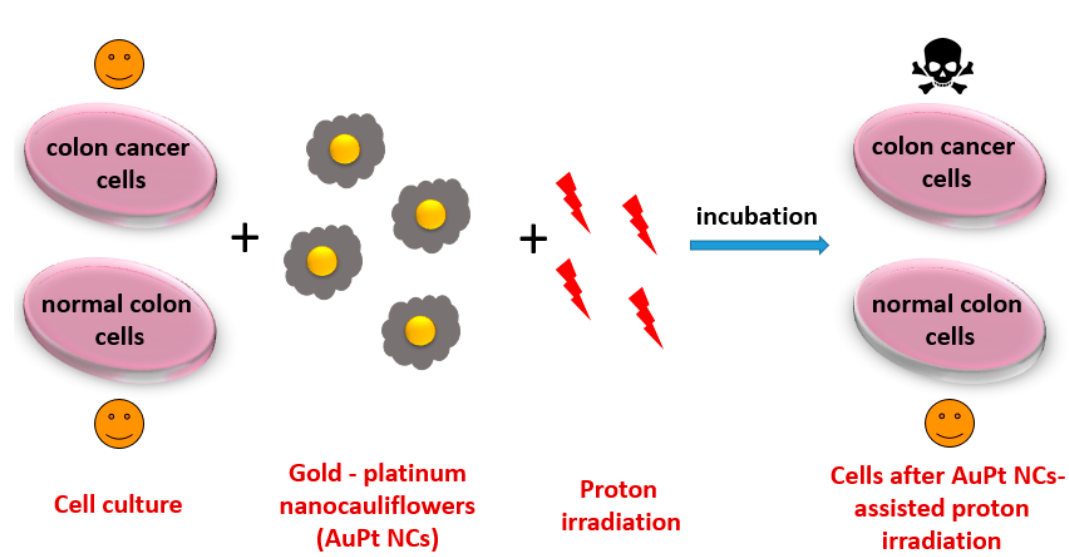
Figure 1. Overview scheme of the investigation procedure.